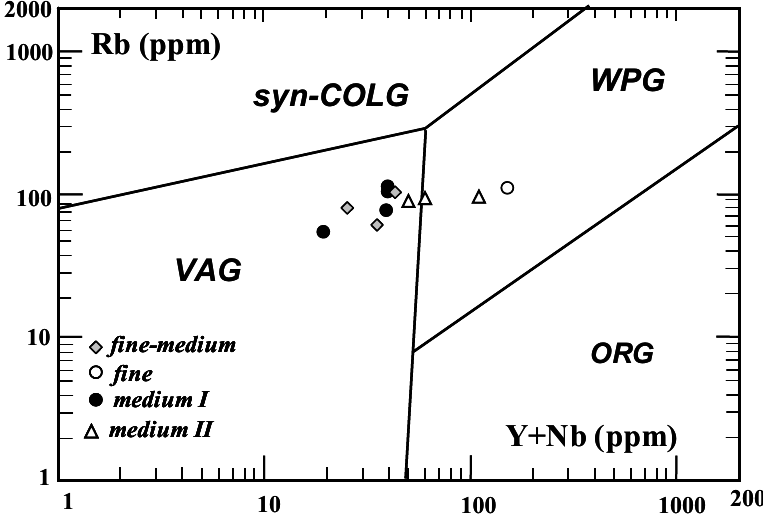
Fig. 4 – Rb × (Y + Nb) discrimination diagram (Pearce et al. 1984) for selected samples of the Glória